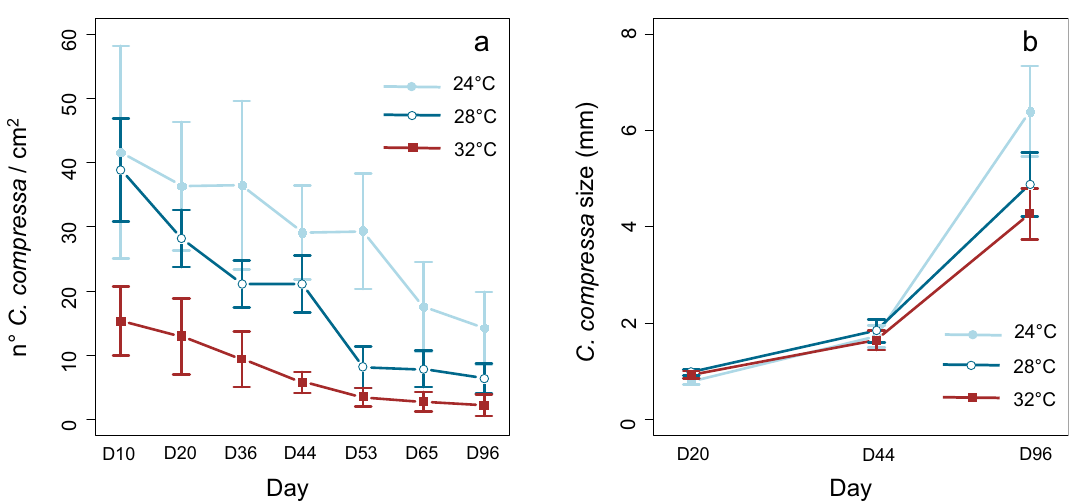
Figure 2. Density ( a ) and size ( b ) of recruits of C. compressa as a function of temperature during the first experiment (96 days). The errors bars show the confidence